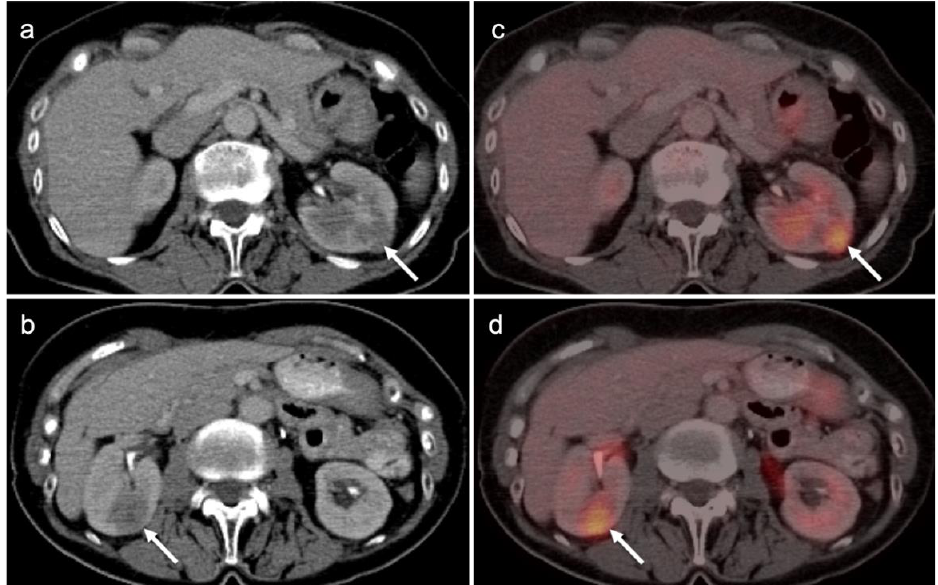
Figure 49. Renal lymphoma on FDG PET-CT. ( a , b ) Numerous hypermetabolic renal nodules are present in both kidneys, as shown on axial ( a ) and coronal ( b ) FDG PET-CT images (white arrow- heads); ( c ) Multiple hypermetabolic nodules are present within the lungs (also lymphoma), as shown on coronal FDG PET-CT image (white arrows). This was diffuse large B-cell lymphoma with renal and lung involvement.